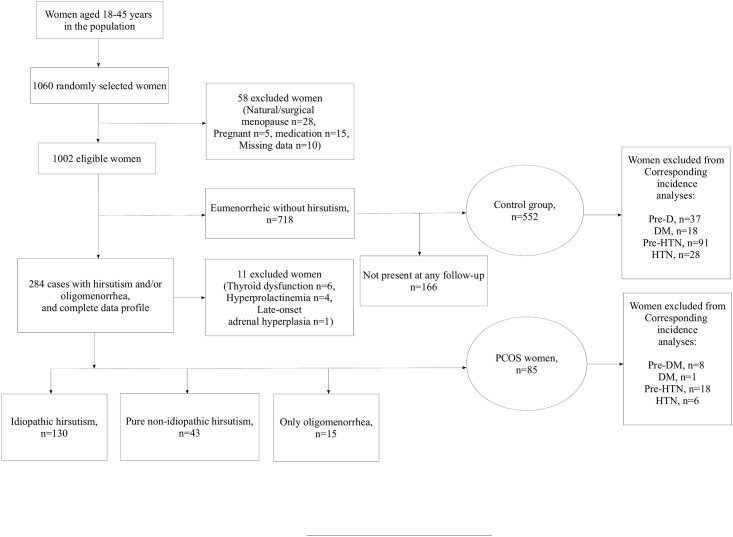
Overview of the study. (Note: The number of cases and controls diagnosed with pre-DM, DM, pre-HTN, and HTN were excluded in the corresponding analyses to report incidence rates of each disorder.)